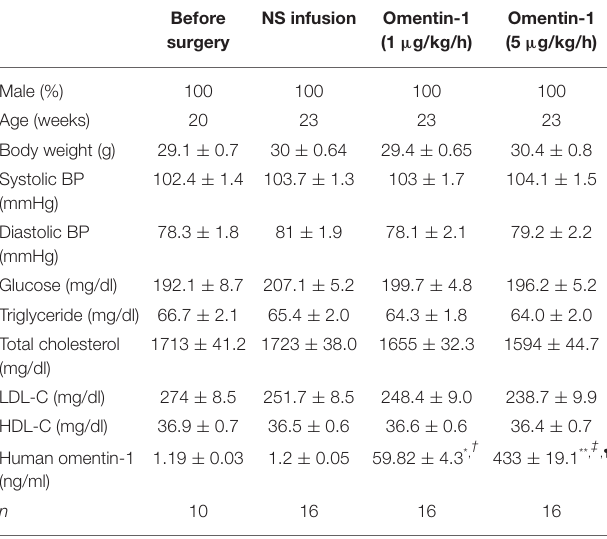
TABLE 3 | Characteristics of ApoE − / − mouse. Before surgery